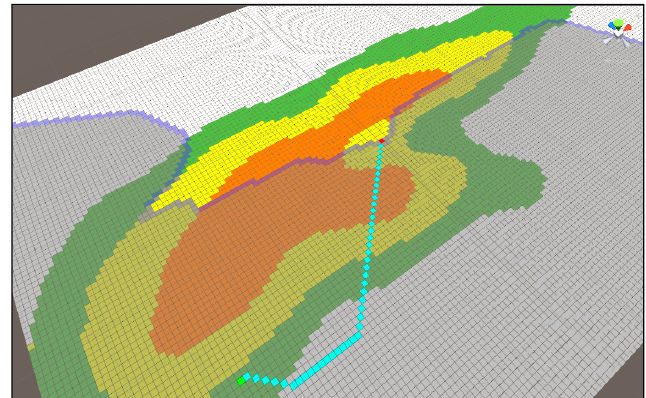
Figure 18. Shortest distance display using multi-extra.